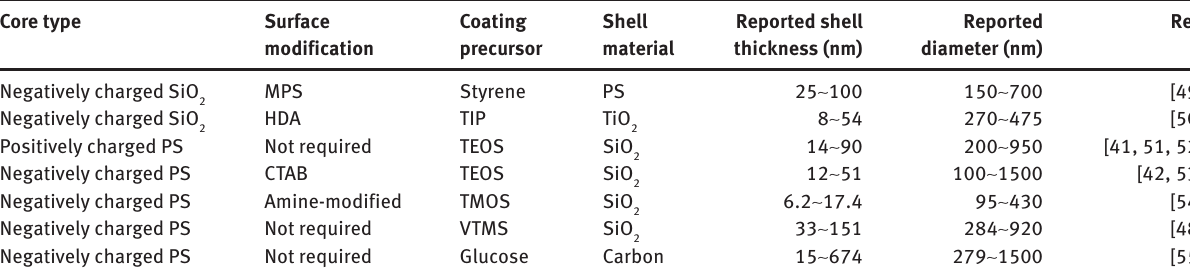
Table 1: Overview of some of hard templating methods to synthesize monodisperse hollow spheres with uniform shell. Core